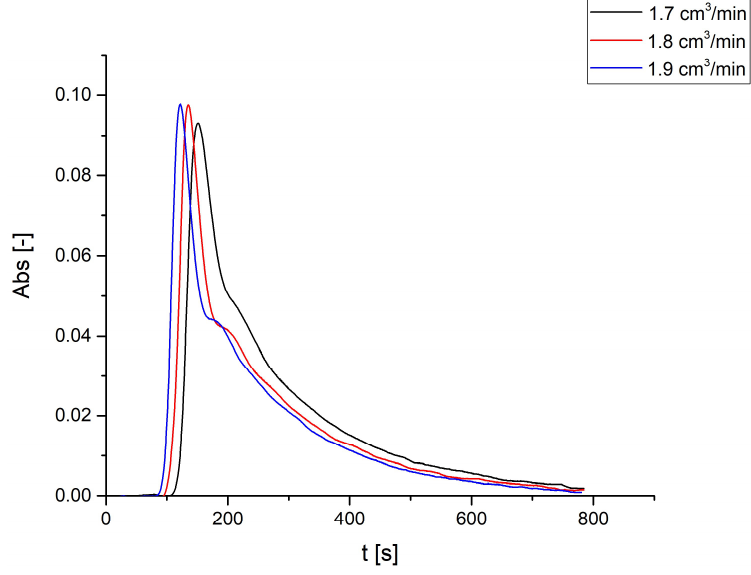
Figure 5. UV spectra of LA 6 M pulses at 313 K and different flow rates.